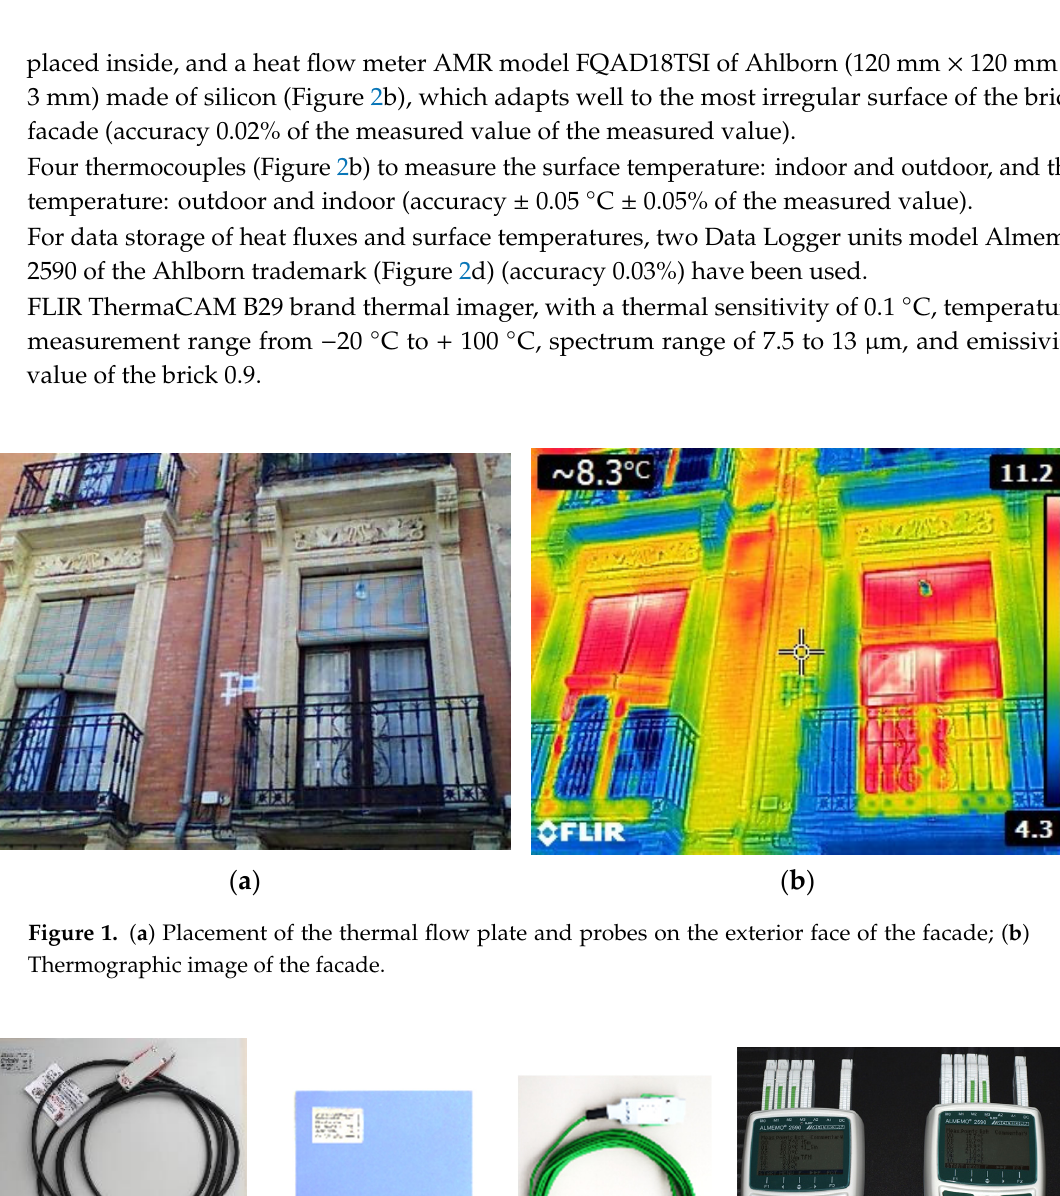
Figure 2. ( a ) Thermal flow plate placed inside; ( b ) thermal flow plate placed outside; ( c ) thermocouple; ( d ) data logger.